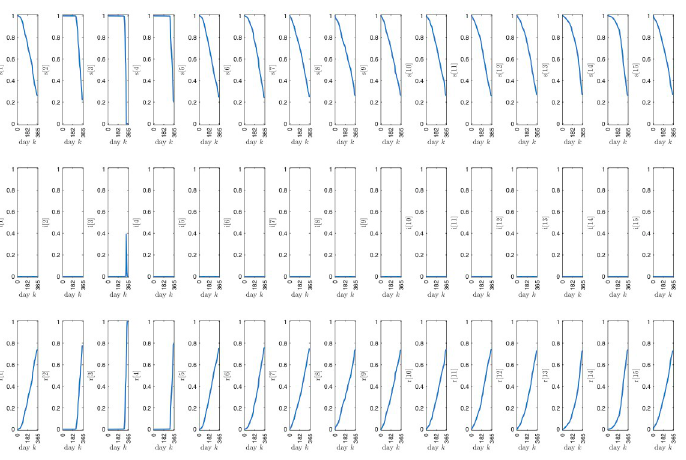
Fig 7. Evolution of the proposed SIR model accounting for the effect of social distancing and vaccines, based on the found solution. The first, second and third row of plots correspond to the fraction of susceptible, infected and removed individuals, respectively, while the k -th column of plots corresponds to the k -th age